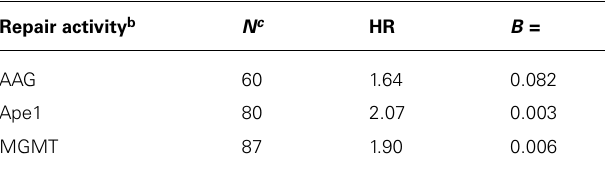
Table 2 |Association ofAAG,Ape1, and MGMT activity with GBM resistance to radiation and alkylating agents: one laboratory’s experience a